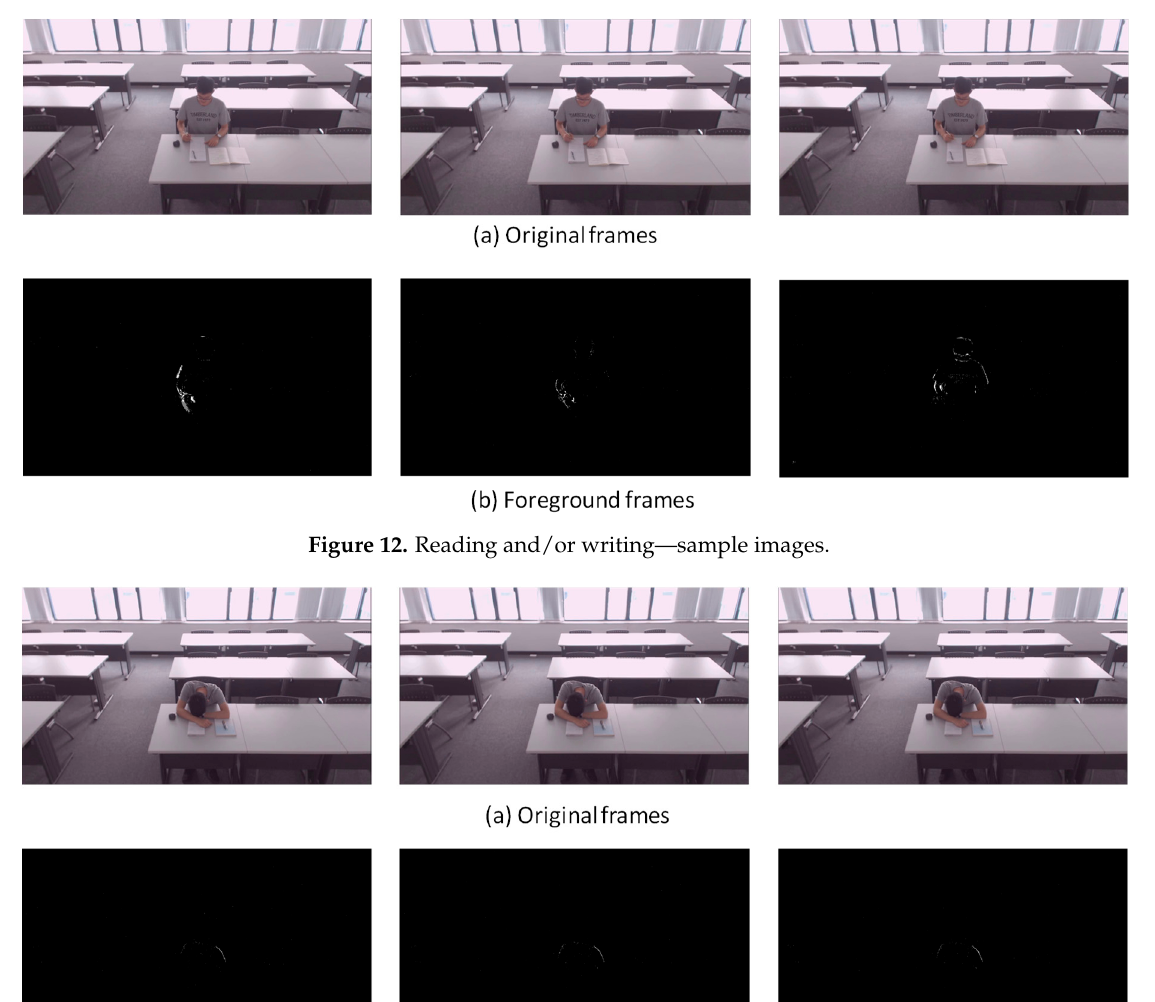
Figure 11. Standing relaxed—sample image.